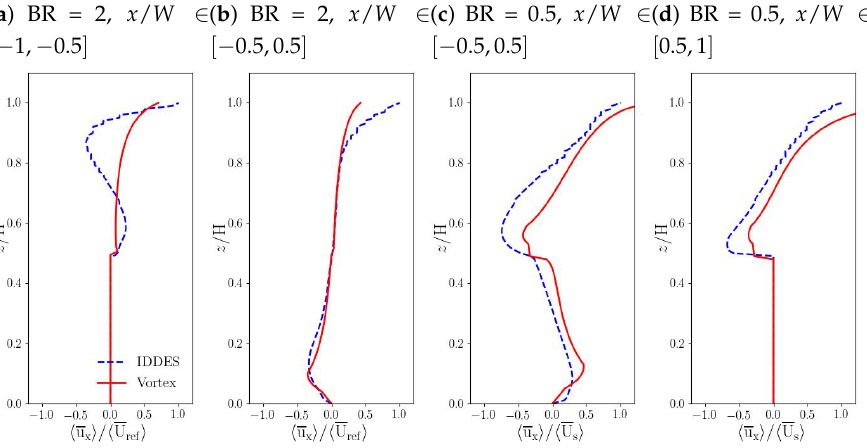
Figure A7. As in Figure 10, but for the streamwise velocity component over the subregions. ( a , b ) step- up canyon; ( c , d ) step-down